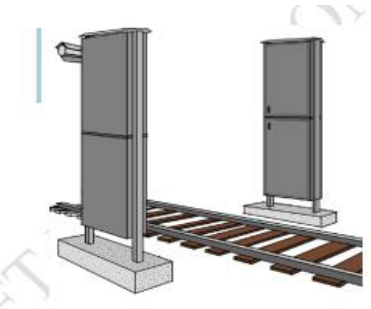
Figure 16. Railroad nuclear material monitor with CCTV [19]